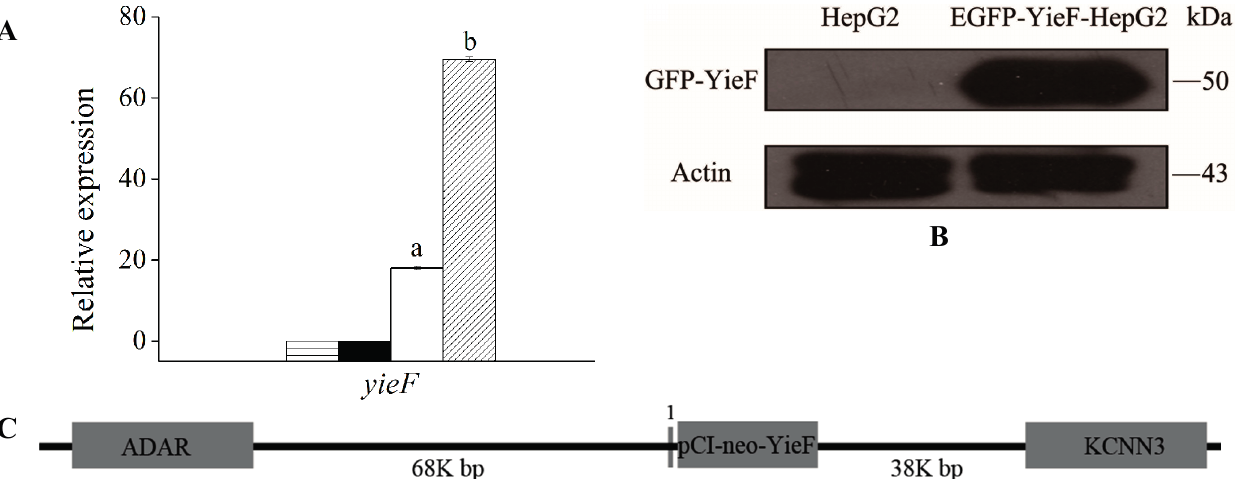
Figure 1. ( A ) The expression levels of gene y ieF in different conditions determined by qRT-PCR. Relative level of yieF mRNA was measured in HepG2 ( ▤ ), Cr(VI)-treated HepG2 ( ■ ), HepG2-YieF ( ▢ ) and Cr(VI)-treated HepG2-YieF ( ▨ ) cells. Data were normalized to β -actin expression as a housekeeping gene. The values are the mean of four replicates. There are significant differences ( p < 0.05) between the two bars marked a and b; ( B ) Detection of GFP-YieF fusion protein by western blotting. Molecular weight of GFP-YieF is about 50 kDa; ( C ) The integration of yieF in human chromosome 1. Grey boxes on the 5 ʹ and 3 ʹ sides of yieF indicated genes located on Chr 1. Grey line immediately upstream of yieF marked 1 indicate predicted TF binding sites including TBP, Sp1 and CBP100 binding sites. The diagram was not drawn to scale. ADAR, adenosine deaminase, RNA-specific; KCNN3, potassium channel, calcium activated intermediate/small conductance subfamily N α , member